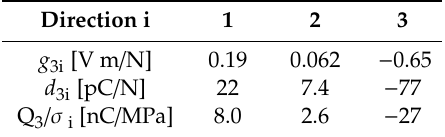
Table 2. Piezoelectric moduli of force measurements and ratios of generated charge and stress. Direction i 1 2